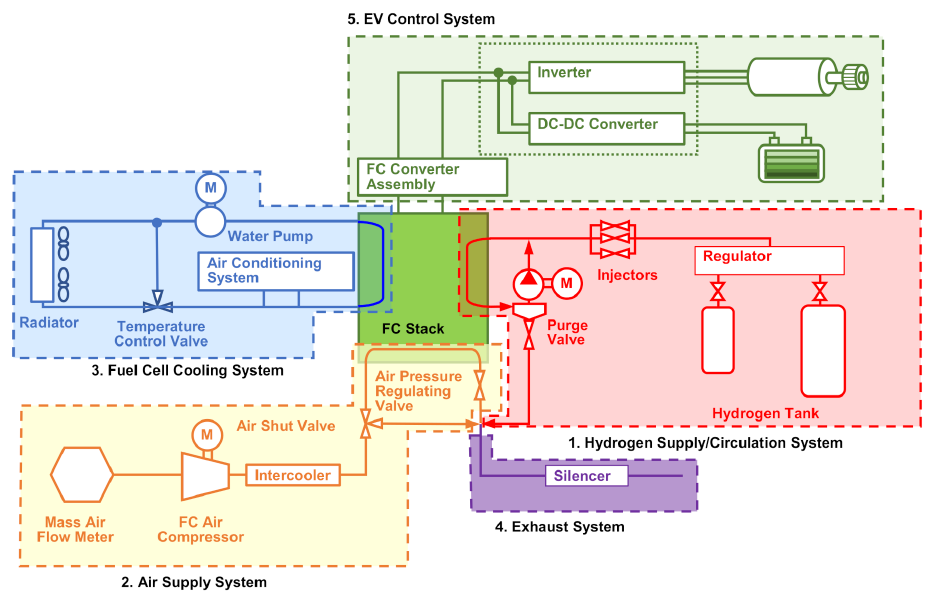
Figure 3. Toyota Mirai hydrogen system component layout (based on [33]).